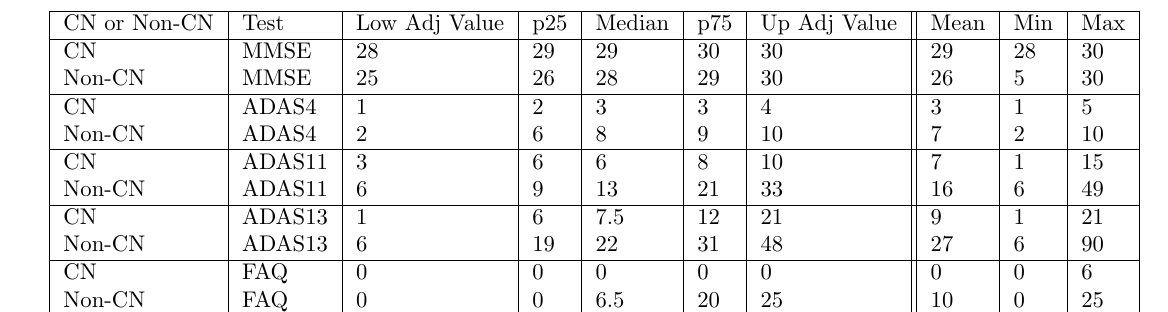
Fig. 16 Ranges of test data split by the predicted diagnosis (CN or non-CN) assigned by the diagnosis model at month 72 (with normal